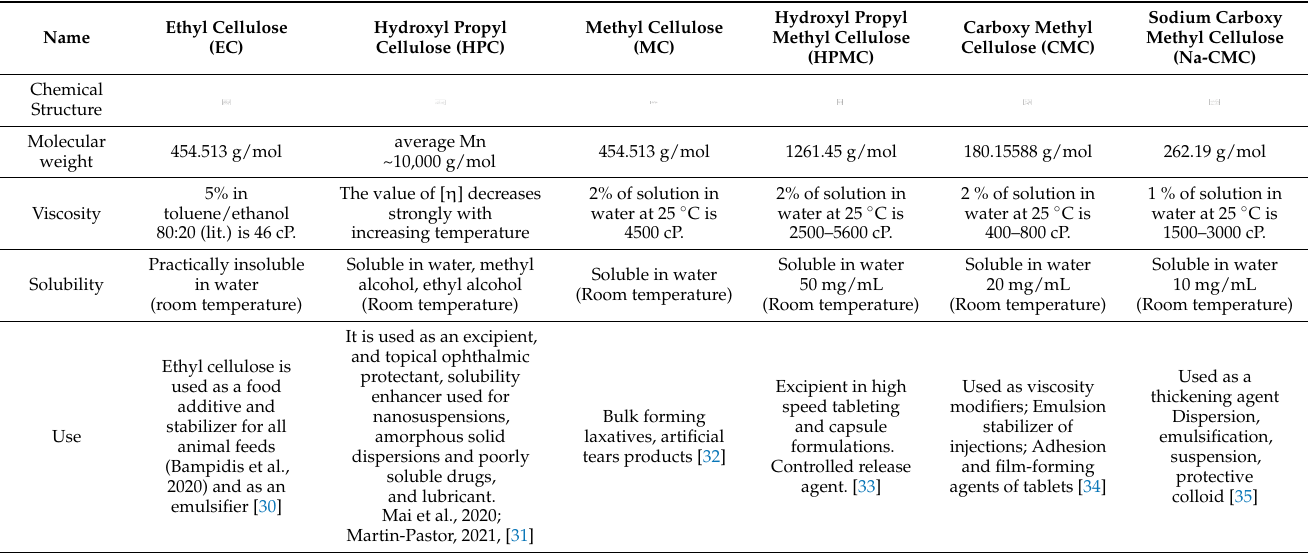
Table 1. Illustration of physiochemical properties of different cellulose